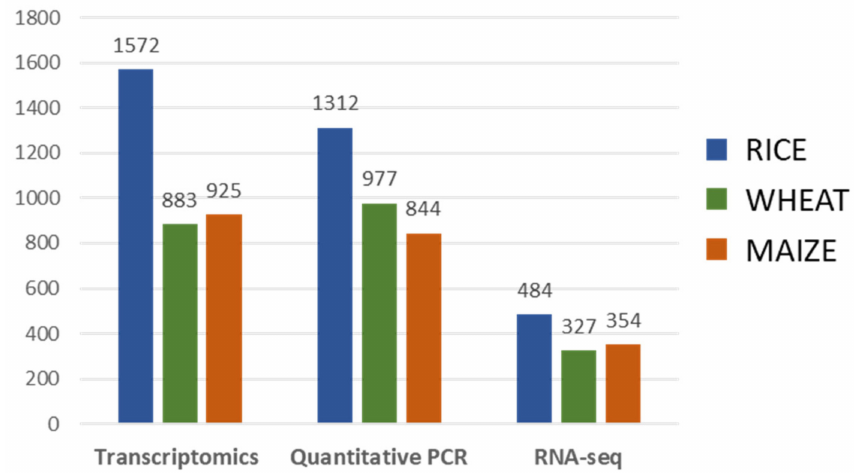
Figure 4. Number of bibliographic records referring to main modern approaches for gene expression analysis in rice, wheat, and maize (source: Web of Science database, all years available; accessed on 15 December